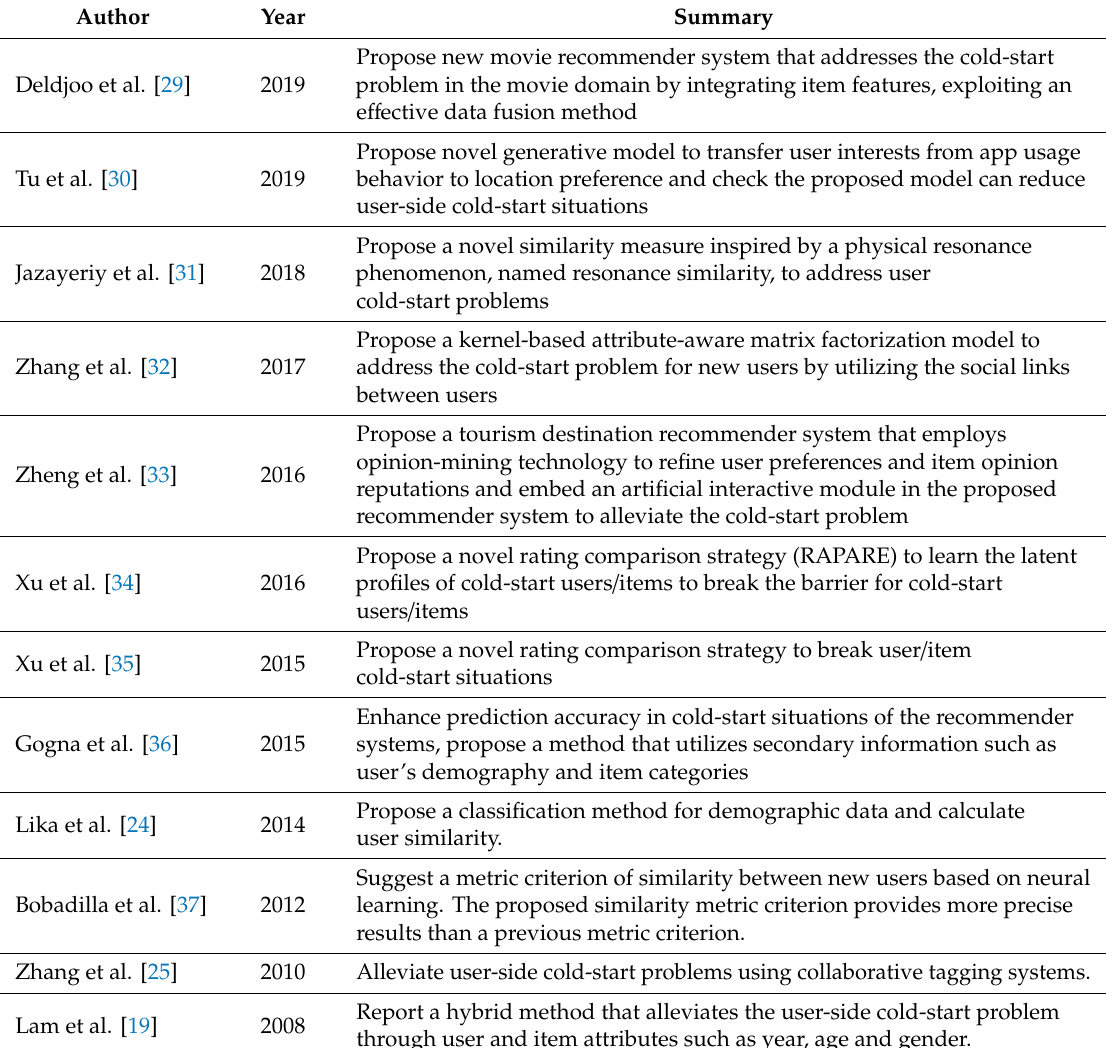
Table 2. Studies on the cold-start